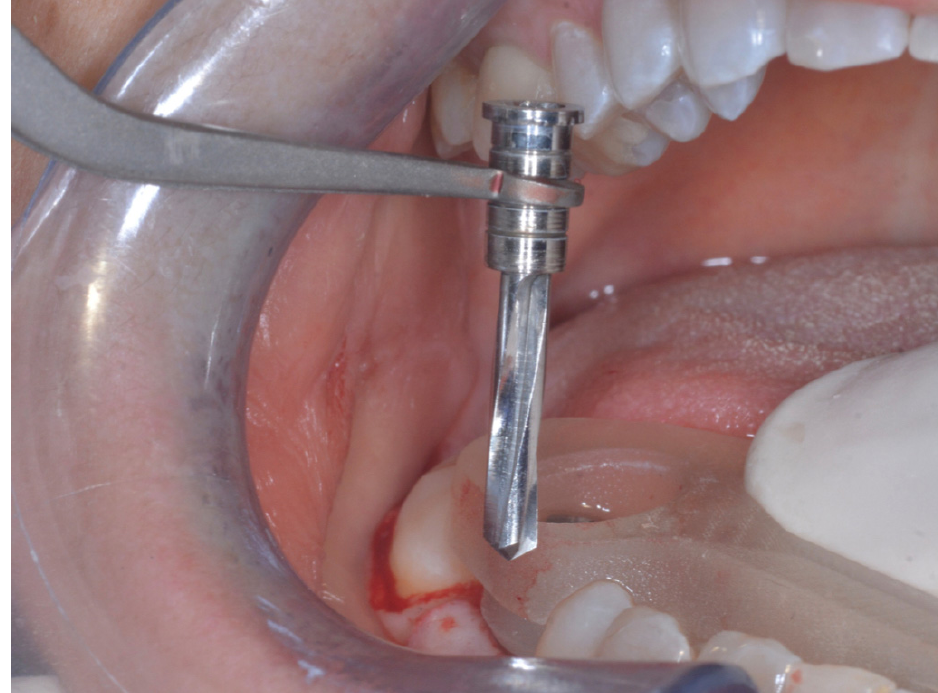
Figure 12. Intraoperative view of the progressive working drills (notches at working depth: 7, 8.5, 10, 11.5, and 13 mm; available diameters 2, 2.5, 3, and 3.25 mm).